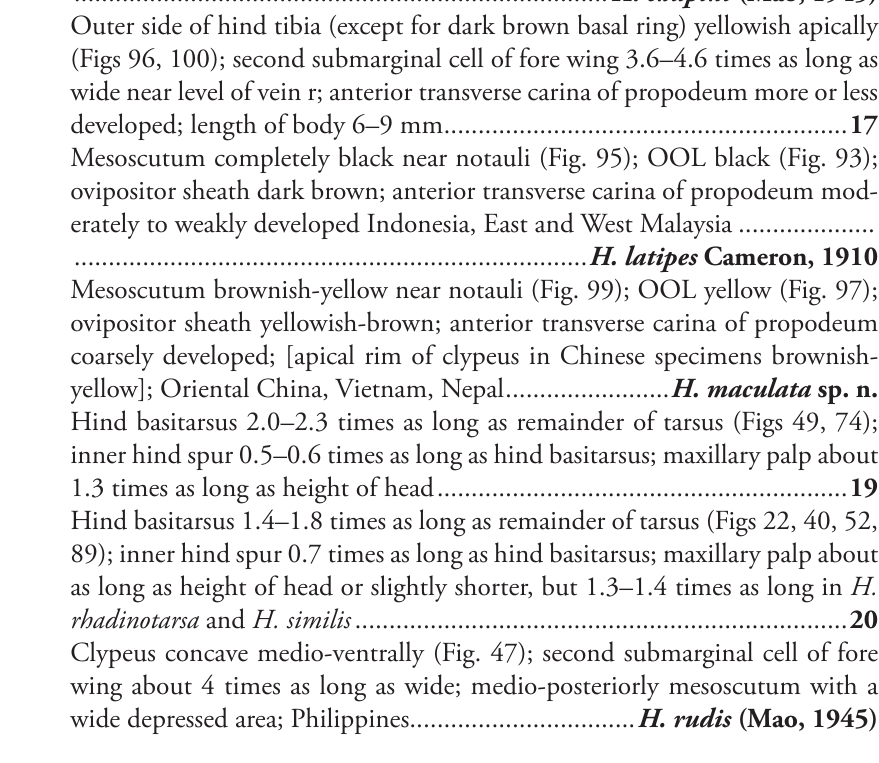
Ventral margin of clypeus weakly but evenly curved medially (Figs 53, 56, 59); temple largely smooth, but coarsely punctate in H. basilaris ; hind basi- tarsus distinctly narrowed apically (Figs 55, 58), but slightly so in H. chapini (Fig. 61); length of body 6–9 mm, but in H. chapini up to 5 mm ............. 15 – Ventral margin of clypeus nearly straight to slightly concave medially (Figs 17, 35, 47, 50; 72, 87); temple more or less punctate; hind basitarsus slightly nar- rowed apically (Figs 22, 40, 49, 52, 74, 89); length of body 4.0–6.3 mm ..... 18 15 Head coarsely punctate (Fig. 53); hind basitarsus largely yellowish-brown; dorsal margin of clypeus evenly curved (Fig. 53); second-fifth hind tarsal seg- ments less slender (Fig. 55); vein SR1 of fore wing almost vertical basally; [hind coxa with two black spots dorsally]; Indonesia, *East Malaysia ............ – Head smooth or mainly finely punctate (Figs 56, 59); hind basitarsus largely dark brown or blackish; dorsal margin of clypeus straight or slightly sinuate (Figs 56, 59); second-fifth hind tarsal segments slender (Figs 58, 61); vein SR1 of fore wing distinctly oblique basally ................................................ 16 16 Outer side of hind tibia partly dark brown apically (Fig. 61); second sub- marginal cell of fore wing 3.3–4.0 times as long as wide near level of vein r; second-fifth hind tarsal segment less robust (Fig. 61); anterior transverse carina of propodeum absent; length of body 5.0–6.1 mm]; Philippines ........ – Outer side of hind tibia (except for dark brown basal ring) yellowish apically (Figs 96, 100); second submarginal cell of fore wing 3.6–4.6 times as long as wide near level of vein r; anterior transverse carina of propodeum more or less developed; length of body 6–9 mm ........................................................... 17 17 Mesoscutum completely black near notauli (Fig. 95); OOL black (Fig. 93); ovipositor sheath dark brown; anterior transverse carina of propodeum mod- erately to weakly developed Indonesia, East and West Malaysia .................... – Mesoscutum brownish-yellow near notauli (Fig. 99); OOL yellow (Fig. 97); ovipositor sheath yellowish-brown; anterior transverse carina of propodeum coarsely developed; [apical rim of clypeus in Chinese specimens brownish- yellow]; Oriental China, Vietnam, Nepal ........................ H. maculata sp. n. 18 Hind basitarsus 2.0–2.3 times as long as remainder of tarsus (Figs 49, 74); inner hind spur 0.5–0.6 times as long as hind basitarsus; maxillary palp about 1.3 times as long as height of head ............................................................ 19 – Hind basitarsus 1.4–1.8 times as long as remainder of tarsus (Figs 22, 40, 52, 89); inner hind spur 0.7 times as long as hind basitarsus; maxillary palp about as long as height of head or slightly shorter, but 1.3–1.4 times as long in H. 19 Clypeus concave medio-ventrally (Fig. 47); second submarginal cell of fore wing about 4 times as long as wide; medio-posteriorly mesoscutum with